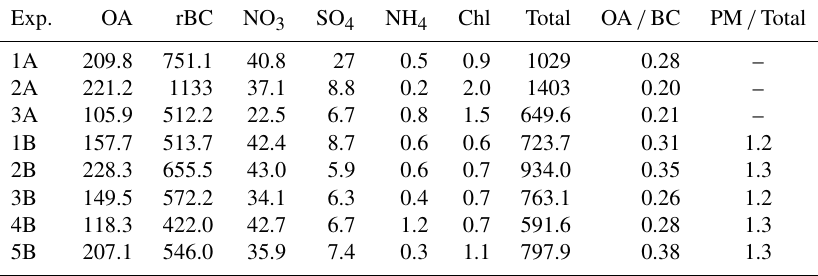
Table 2. PM emissions (mgkg − 1 fuel) of the AMS species and ratios of OA to rBC and PM (TEOM) to AMS total. Exp.